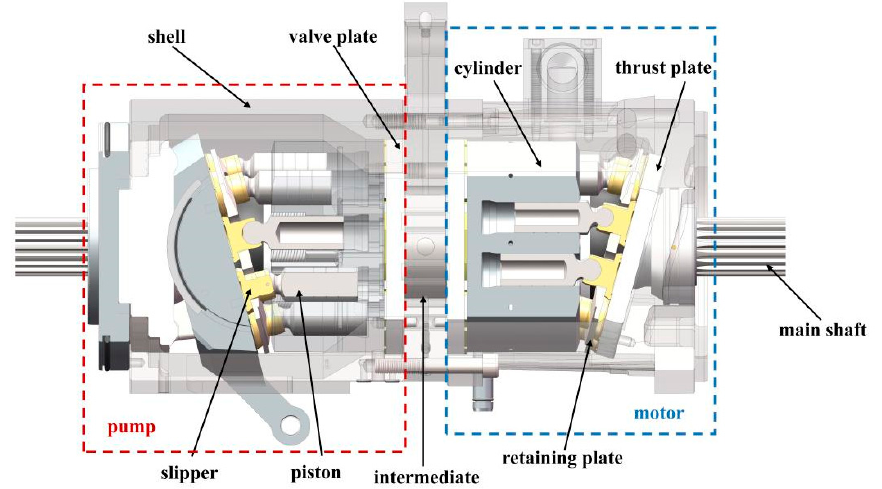
Figure 1. The schematic view of the closed circuit axial piston transmission.